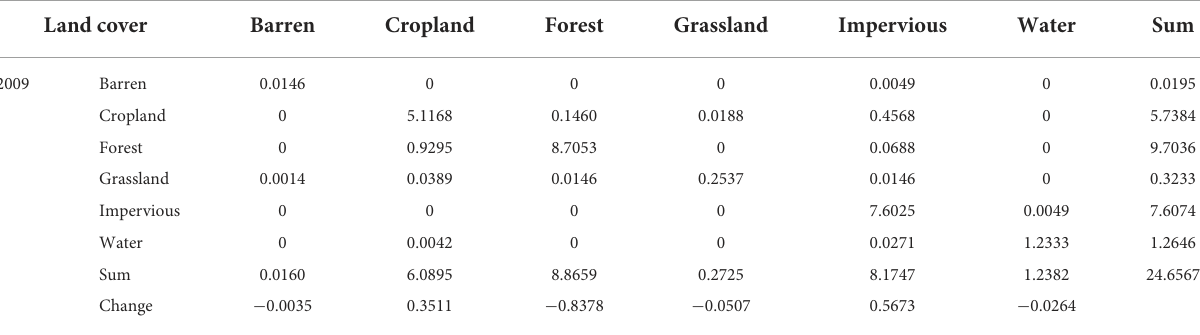
TABLE 3 Land use change from 2009–2014 (km 2